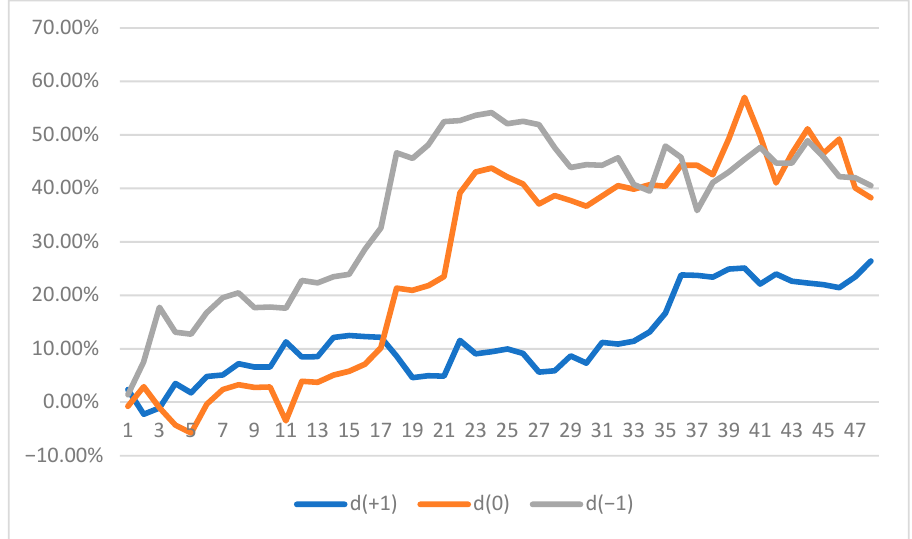
Figure 2. Trade by trade profit/loss dynamics: daily data.